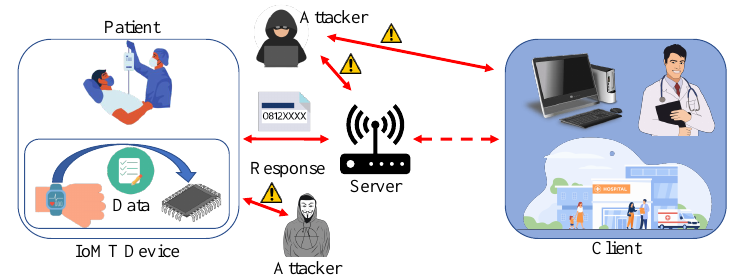
Figure 6. Overview of the Proposed Method.